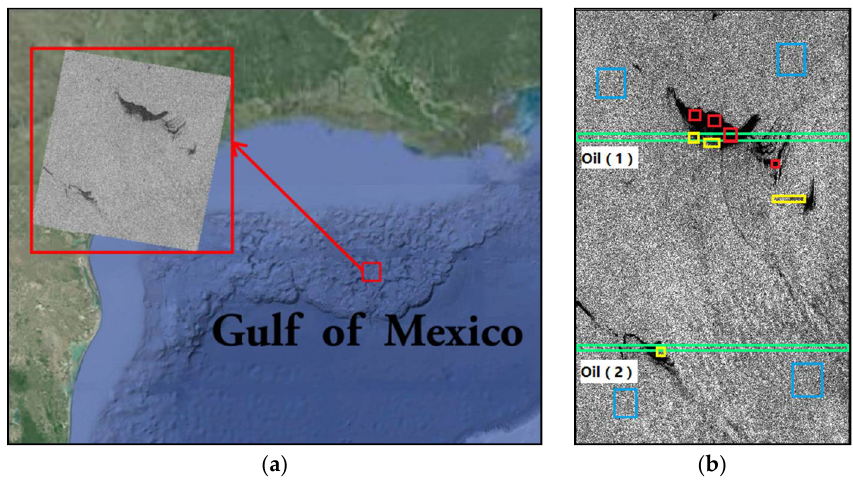
Figure 2. Natural oil seeps scene of RADARSAT-2 (8 May 2010): ( a ) Location of the acquired image; ( b ) Intensity images (σ VV ). The colored boxes indicate sample regions used in noise equivalent sigma zero (NESZ) analysis (blue: sea, red: thick oil region, yellow: thin oil region). The green rectangles in ( b ) denote areas that include thick oil areas, thin oil areas, and clean-ocean surface areas.